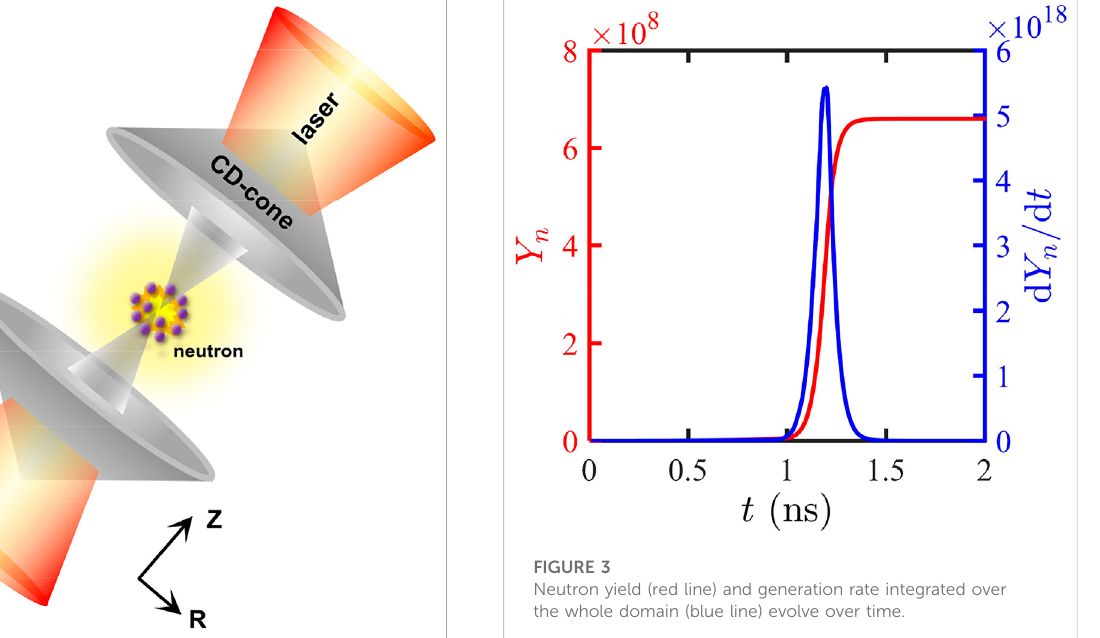
FIGURE 2 Schematic of neutron source from head-on collision of counter-propagating plasma jets.